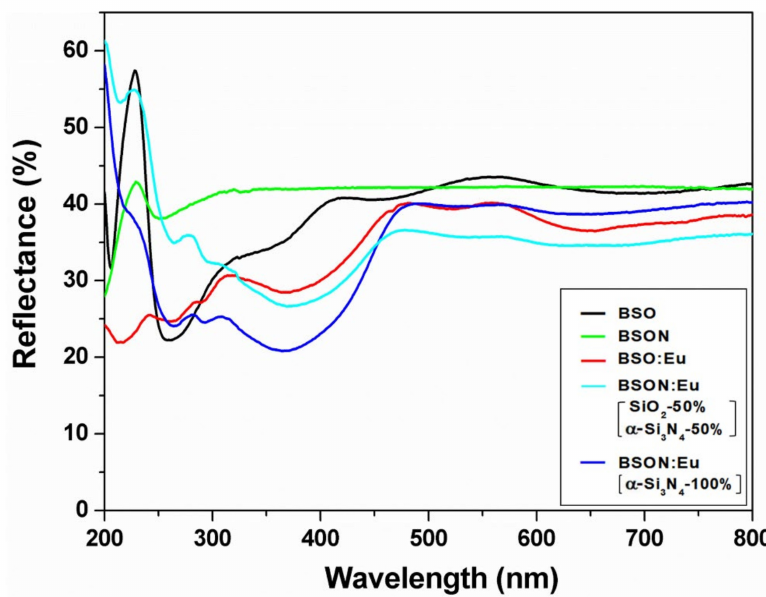
Figure 10. Di ff use reflectance spectra of BSO, BSO:Eu 2 + , BSON, and BSON:Eu 2 + .